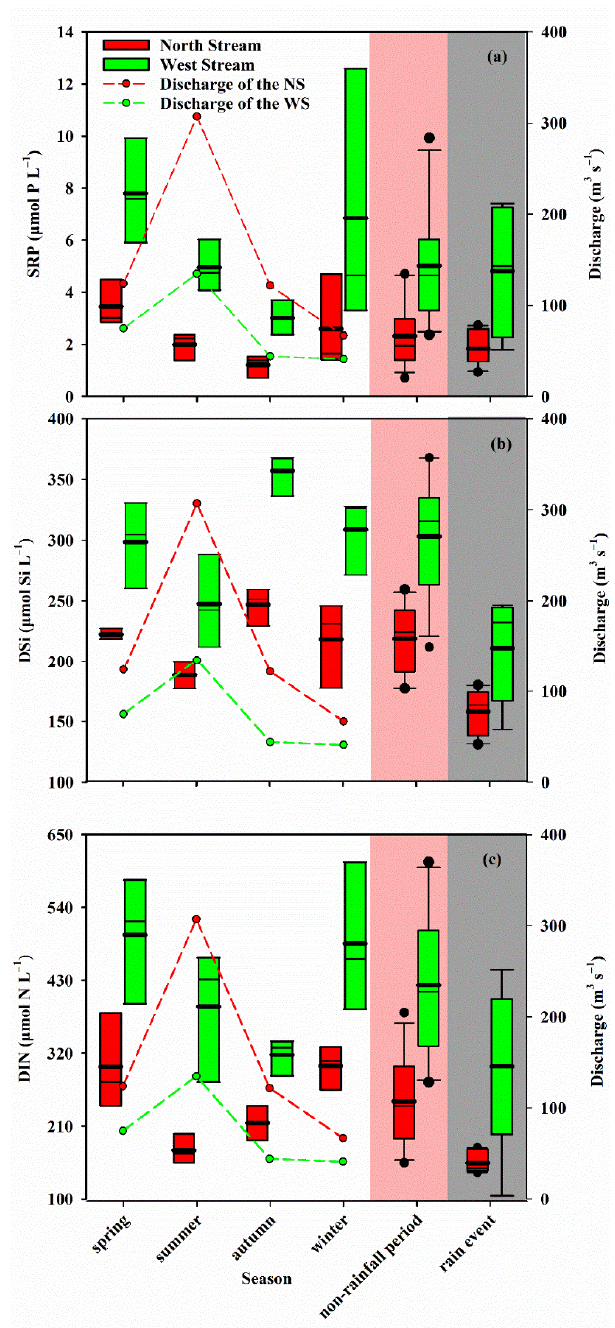
Figure 5. Seasonal changes in nutrients (( a ) DIN, ( b ) SRP and ( c ) DSi) and river discharge in the NS and WS during the non-rainfall period. The red and gray shaded areas represent the overall changes in nutrients during the non-rainfall period and rain event, respectively. The black and bold black horizontal lines in the boxes indicate the median and the mean, while the two horizontal lines at the ends of the box sides represent the third and first quartile.